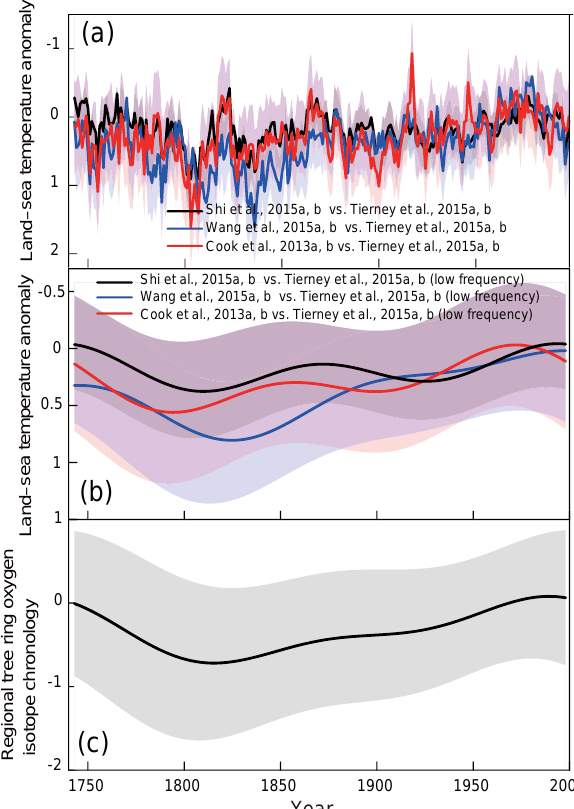
Figure 10. (a) Land–ocean temperature anomaly based on three summer temperature reconstruction for the Tibetan Plateau and one Indian Ocean SST reconstruction; (b, c) low-frequency variations of land–sea thermal contrasts and the H5 regional tree-ring δ 18 O chronology. Shades with different colors indicate uncertainty for each time